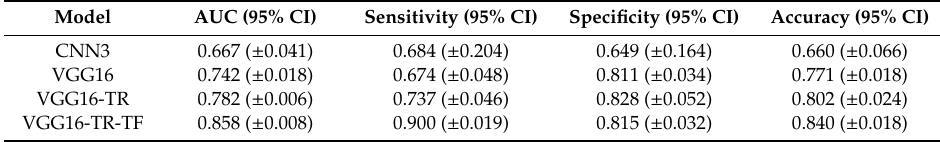
Table 2. Osteoporosis screening accuracy of convolutional neural network models in this research.